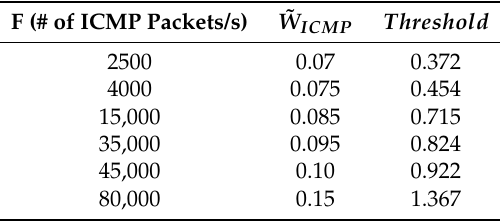
Table 5. Optimized monitoring time window ˜ W ICMP for ICMP attack under different traffic